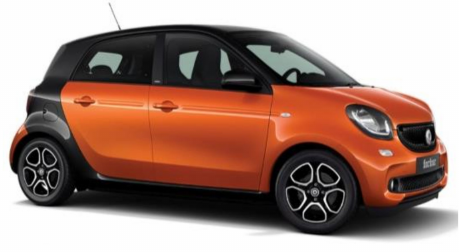
Figure 3. SMART four four.